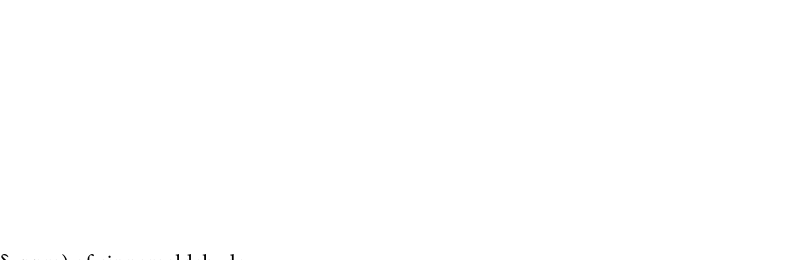
Table 2. Chemical shifts (δ, ppm) of cinnamaldehyde.